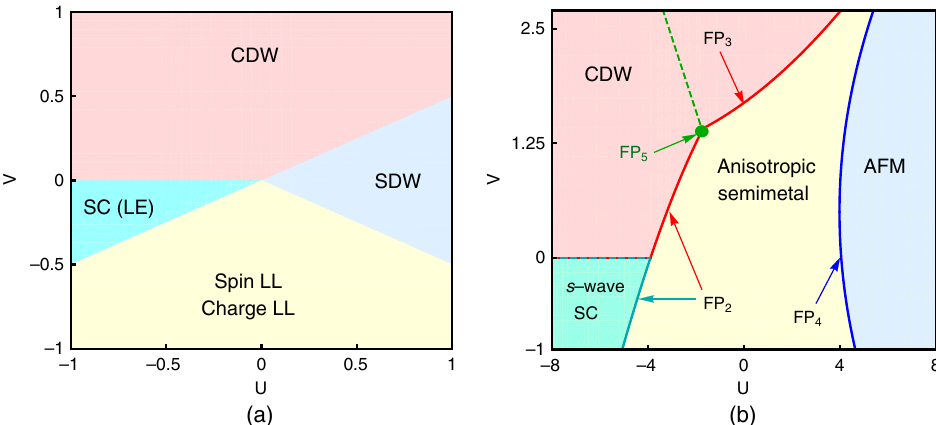
FIG. 4. The phase diagram of the extended Hubbard model for spin- 1 /2 electrons in (a) one dimension and (b) the two-dimensional anisotropic semimetal (ASM), obtained in this work. Here, U and V , respectively, correspond to on-site and nearest-neighbor interactions; see Eq. (8). The 1D extended Hubbard model has been extensively studied; see, e.g., [38 – 41]. Here, we limit attention to the well-known predictions that obtain from bosonization [42,43], expected to hold for sufficiently weak coupling. In 1D, electronic quasiparticles are ill defined for arbitrarily weak interactions. The interacting phases are shown in panel (a) and consist of (i) spin density wave (SDW), (ii) CDW, (iii) Luther-Emery liquid (LE), and (iv) coexisting spin and charge Luttinger liquids (LLs). In the continuum limit, these phases exhibit complete spin-charge separation [43]; the charge is gapped in the CDWand SDW phases, while the spin is gapped in the CDWand LE phases. The latter is a 1D precursor to superconductivity. We obtain a qualitatively similar phase diagram for the ASM, shown in (b). The key differences are that the quasi-long-range-ordered SDW and LE phases are, respectively, replaced with true long-range-ordered AFM and s -wave superconductivity (SC) (at zero temperature), and that the CDW, AFM, and SC orders appear at finite coupling as a result of the vanishing density of states. In (b), we set n ¼ 10 [Eq. (6)] to parametrically suppress higher-dimensional quantum fluctuations (see Sec. V for a detailed discussion); here U and V are dimensionless couplings measured in units of ϵ . The phase diagram (b) is obtained by simultaneously solving the RG flow equations for four-fermion coupling constants and order parameter source terms (see Sec. VII). For V ¼ 0 and sufficiently attractive U < 0 , simultaneous nucleation of CDW and s -wave pairing occurs (dashed red/cyan line). Along this line, pseudospin SU(2) symmetry [44 – 46] gets spontaneously broken. Various quantum critical fixed points FP (see Table IV) control j different segments of the phase boundaries, indicated in panel (b). Fixed points FP 2 exhibit emergent pseudospin SU(2) symmetry, while ; 4 this is broken at FP 3 . In the CDW phase (red region) in panel (b), the dashed green line is a crossover boundary. Above the line of coexistence with the CDW, the s -wave superconductivity exhibits short-range ordering that smoothly vanishes at the dotted green line. This is governed by the bicritical point FP 5 (see Table IV), where the ASM-CDW phase boundary displays a kink (green